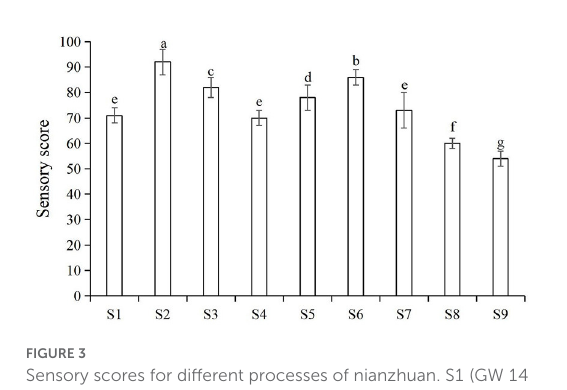
FIGURE3 Sensory scores for different processes of nianzhuan. S1 (GW 14 d, SGWS 25min, CGWP 260min); S2 (GW 14 d, SGWS 26min, CGWP 280min); S3 (GW 14 d, SGWS 27min, CGWP 300min); S4 (GW 16 d, SGWS 25min, CGWP 260min); S5 (GW 16 d, SGWS 26min, CGWP 300min); S6 (GW 16 d, SGWS 27min, CGWP 280min); S7 (GW 18 d, SGWS 25min, CGWP 300min); S8 (GW 18 d, SGWS 26min, CGWP 260min); S9 (GW 18 d, SGWS 27min, CGWP